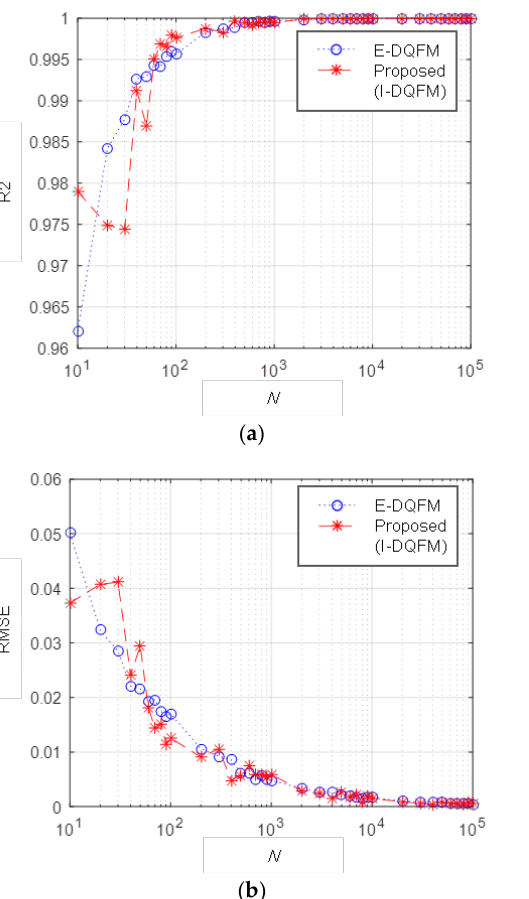
Figure 11. R 2 and RMSE comparison of E-DQFM and proposed method according to the number of samplings “N” regarding (C1 ∪ C2) ∩ C3 example: ( a ) R 2 for independent case; ( b ) RMSE for independent case; ( c ) R 2 for fully correlated case; ( d ) RMSE for the fully correlated case.